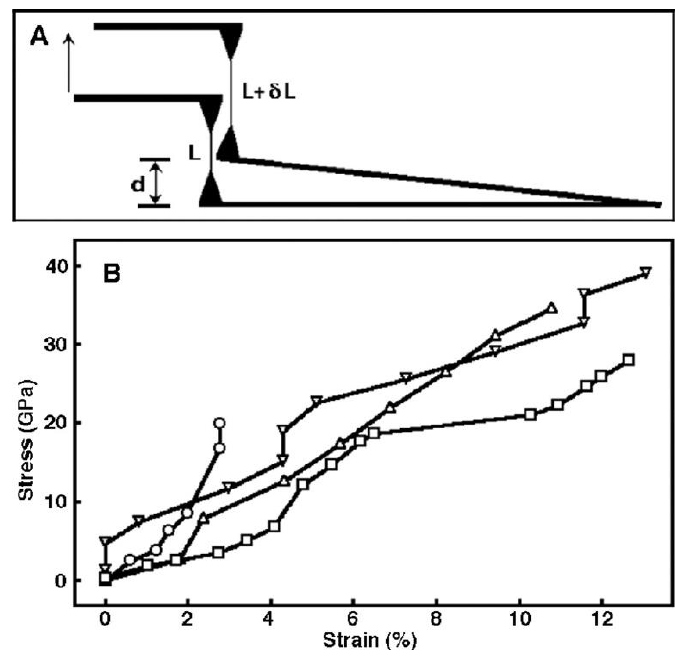
Figure 3. ( A ) Loading configuration and ( B ) stress–strain curves for four individual MWCNTs showing high tensile moduli and strengths [24]. Used with permission from The American Association for the Advancement of Science.